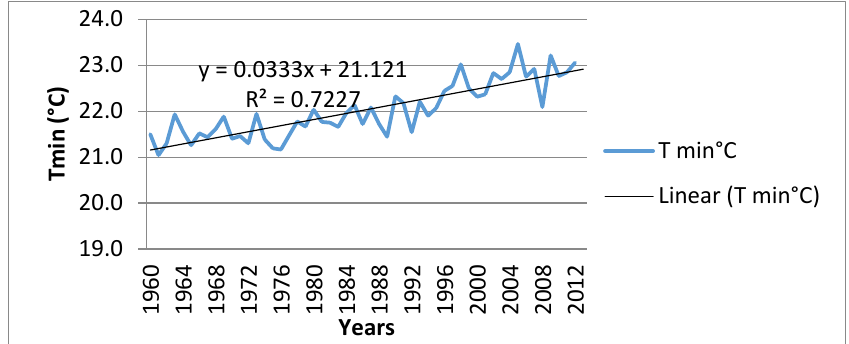
Figure A1. Rainfall trends during 1953–2012 at Ouagadougou.